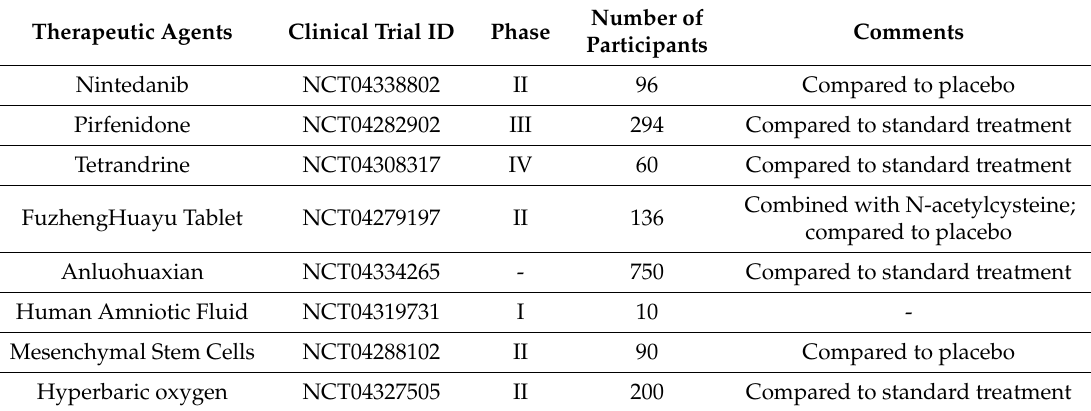
Table 3. Recent clinical trials evaluating therapy of COVID-19-associated pulmonary fibrosis. Therapeutic